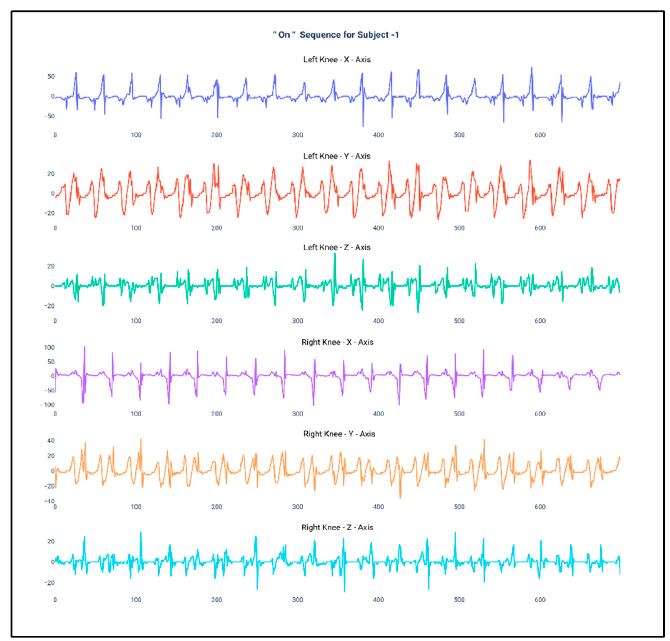
Figure 1. Accelerometer signals of subject 1 for 750 samples during “Off” state.